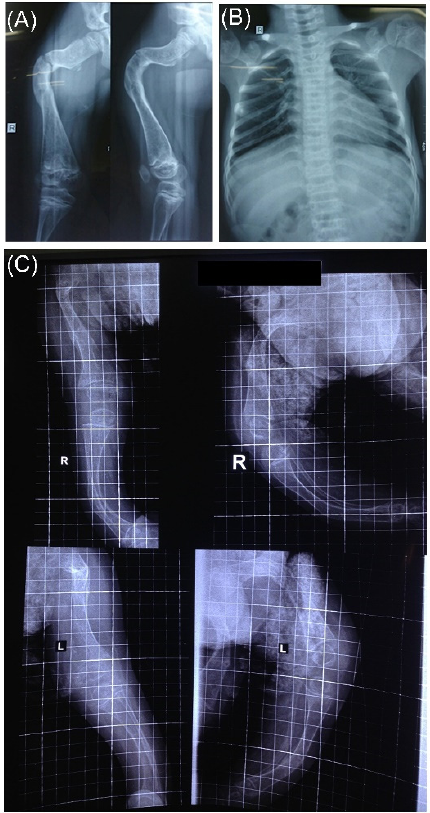
Figure 6. Radiographs of patients VN11 and VN75. ( A ) Radiograph of right lower limb of patient VN11; ( B ) chest radiograph of patient VN11; ( C ) radiograph of lower limbs of patients VN75, R, indicates right; L, indicates left lower limbs.